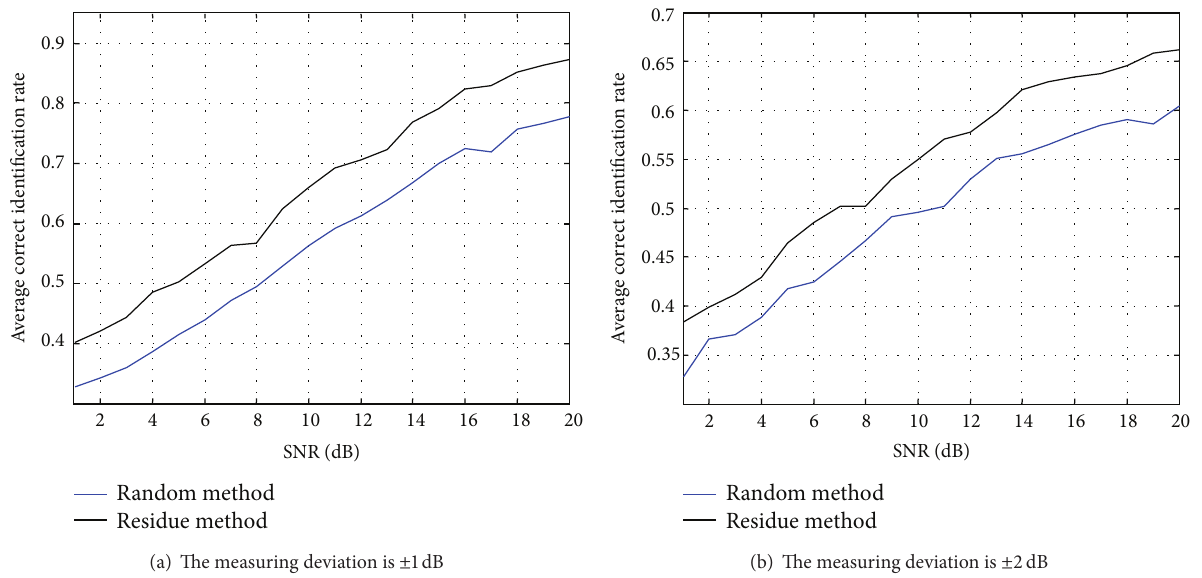
Figure 9: The average correct identification rate changes trend of 6 targets with different SNR when deviations exist. (a) The measuring deviation is ± 1dB. (b) The measuring deviation is ± 2dB.